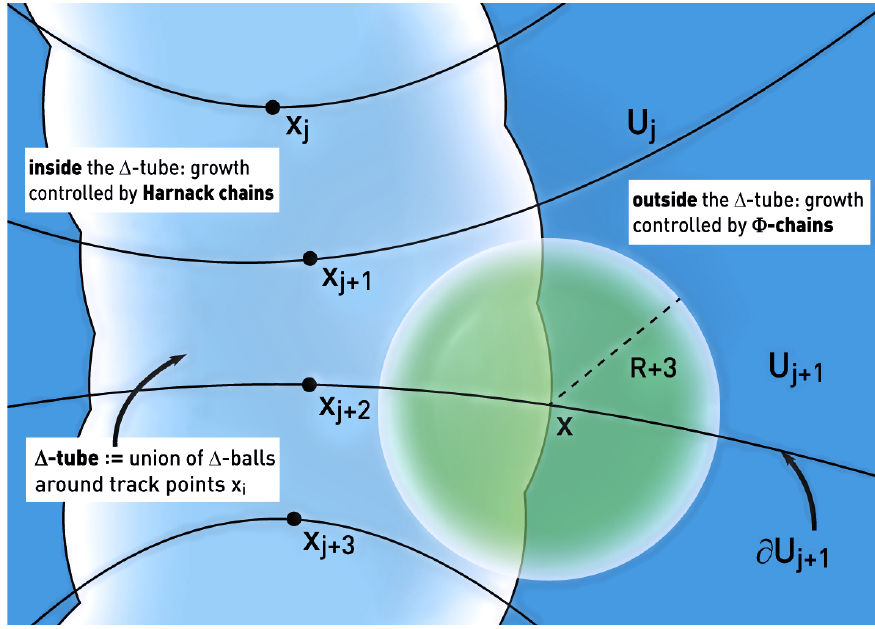
Figure 7: Growth Recovery